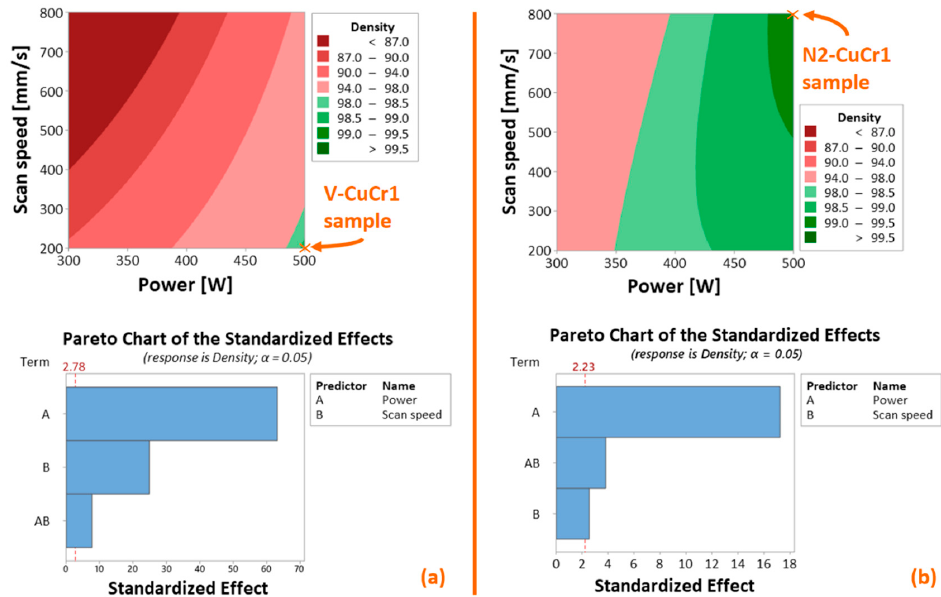
Figure 2. Contour plots of the calculated linear regression models for the LPBF production design of experiment of ( a ) Virgin CuCr1 and ( b ) Surface-modified CuCr1, with corresponding Pareto charts of standardized effects; predictors are laser power [W] and scan speed [mm/s]; response is the measured Archimedes relative density [%]; order two predictors are not displayed since they result as statistically non-significant.